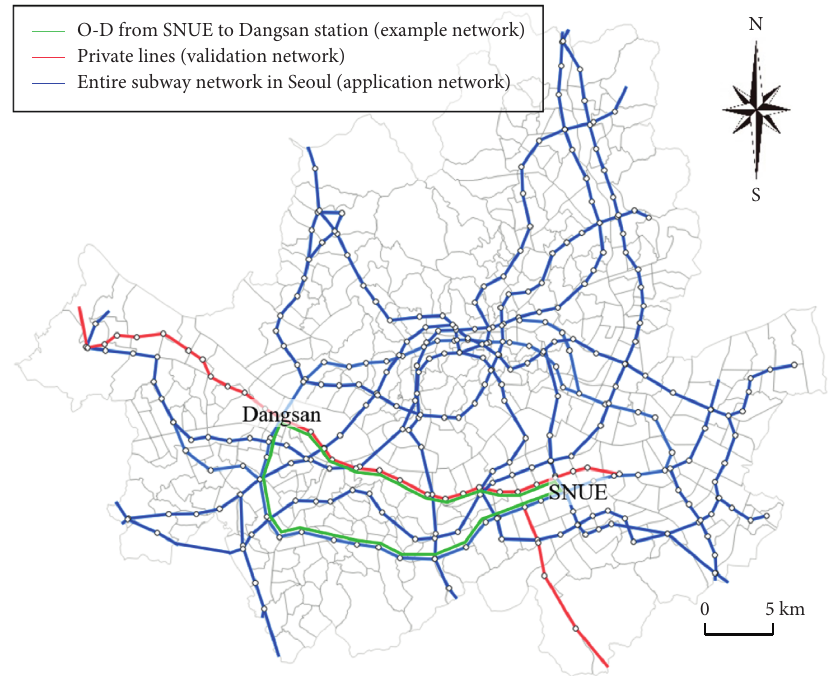
Figure 1: Subway network in